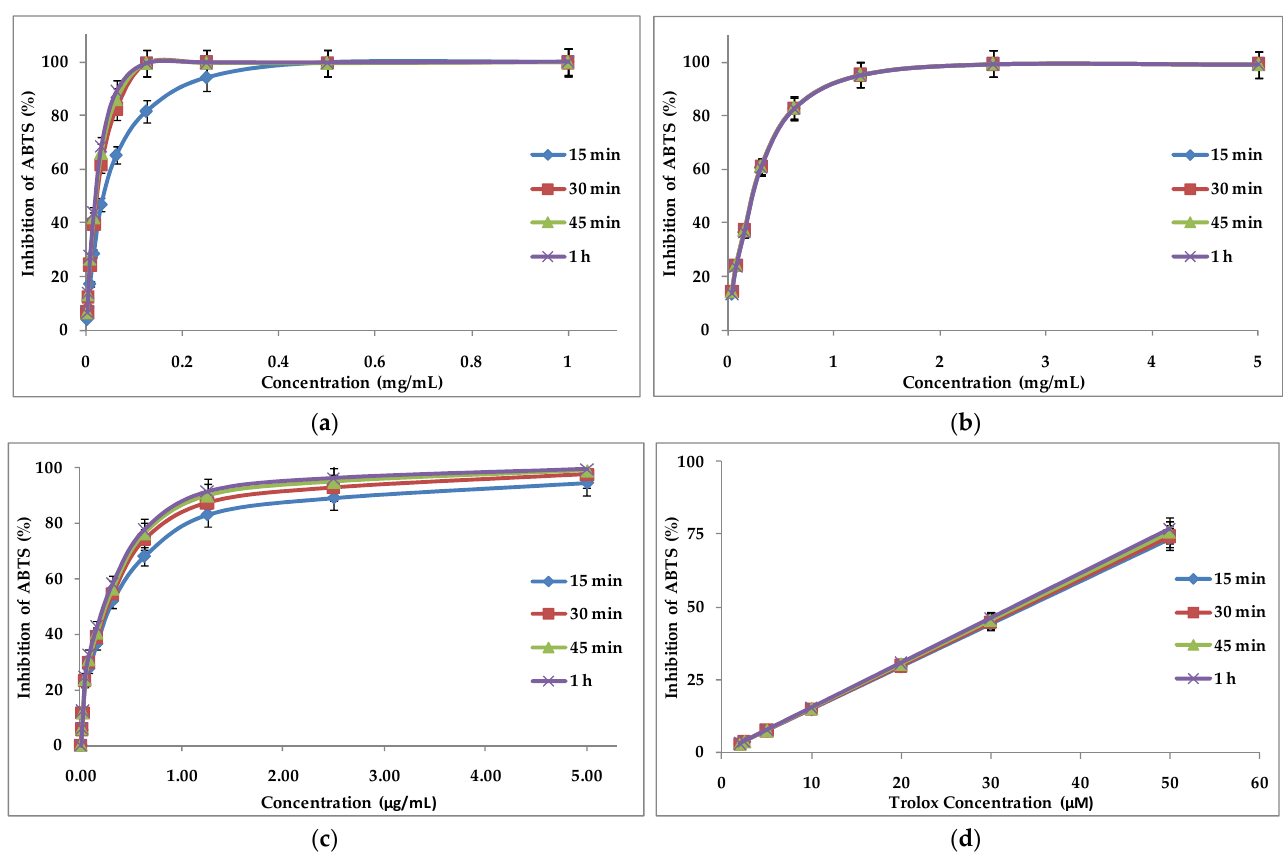
( d ) Figure 4. DPPH scavenging activity of ( a ) methanolic extract, ( b ) ethanolic extracts from A. foeniculum AdB, ( c ) EO from A. foeniculum AdB, and ( d ) gallic acid. Each value is the mean of three replicates ± SD. 2.5.2. ABTS [2,2 ′ -Azinobis-(3-ethylbenzothiazoline-6-sulfonic Acid)] Scavenging Activity